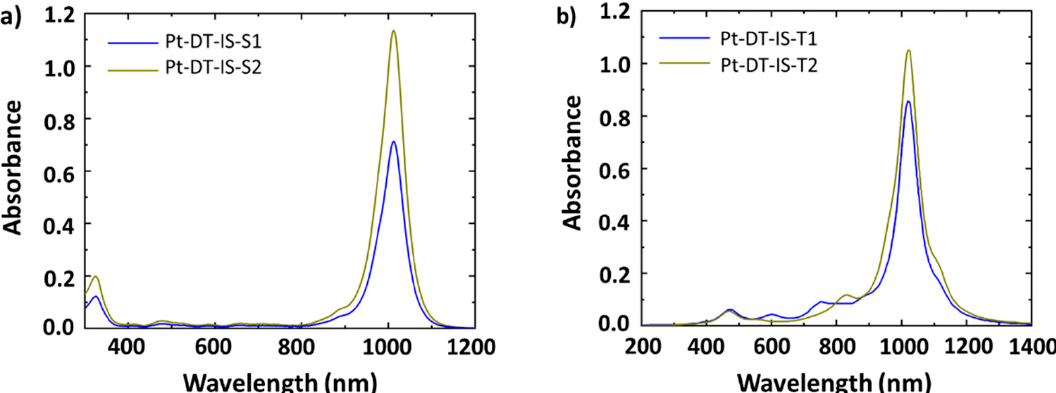
Figure 5. The UV–Vis–NIR absorption spectra of ( a ) Pt-DT-IS-S1 and Pt-DT-IS-S2 dissolved in toluene (concentration: 1.0 × 10 − 5 M, room temperature), and ( b ) Pt-DT-IS with T1 and T2 structures obtained from GW-BSE calculation.